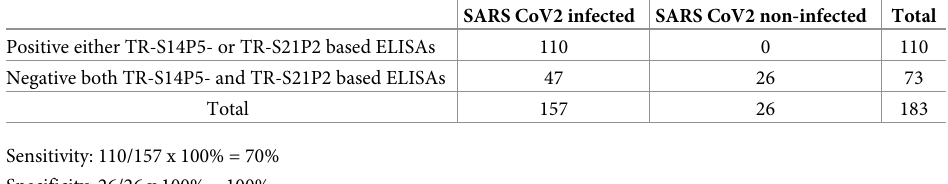
Table 2. Sensitivity and specificity of combined TR-S14P5- and TR-S21P2-based ELISAs at an std-OD cut-off of 0,022 and 0,024, respectively.